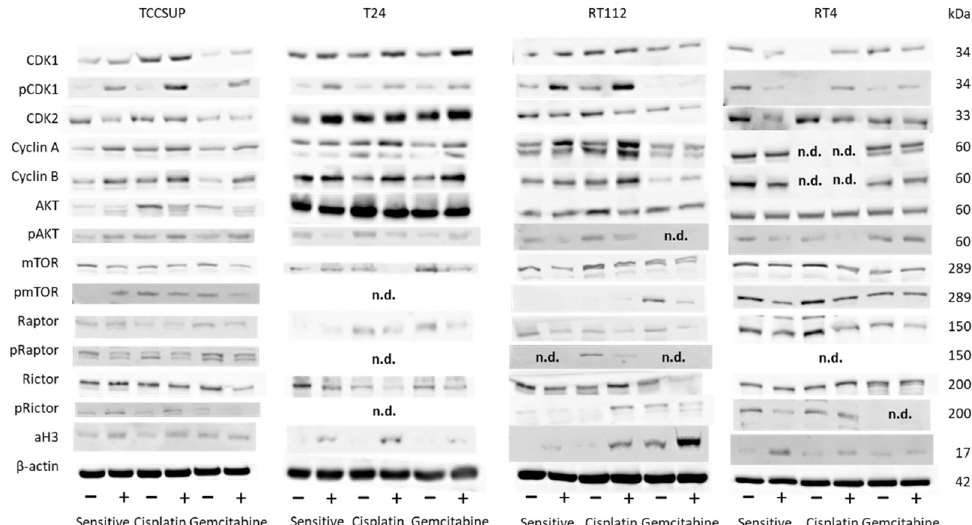
Figure 7. Western blot of cell cycle- and mTOR-related proteins from TCCSUP, T24, RT112, and RT4 lysates of sensitive and cisplatin- and gemcitabine-resistant cells. Tumor cells were pretreated with SFN at a concentration of 20 µM (+). Tumor cells not treated with SFN served as the controls ( − ). β -Actin was used as the internal control. The figure depicts representative blots from n = 3 experi- ments. n.d.: not detectable.